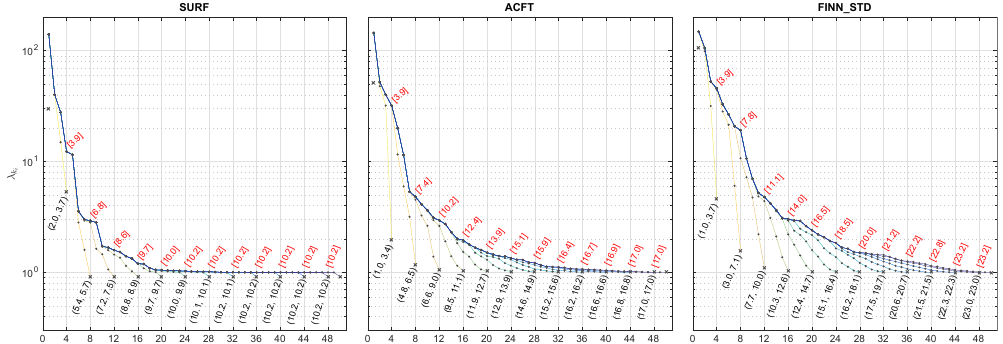
Figure 15. Eigenvalue spectra for SURF, ACFT, and SURF+ACFT in the final outer loop on 23 and 24 June. The lines show the estimate of ] in every fourth inner loop iteration, l . The black numbers in parentheses are the estimates of DOF that include the spectrum [ λ 1 ,...,λ k i = l eigenvalues in the sets (converged to within 5% of the previous estimate, all available). The red numbers in brackets are the truncated estimates of DOF using the most completely converged set of eigenvalues available in the 50th